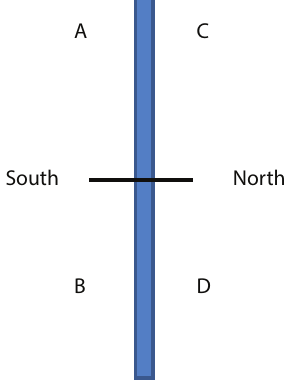
Figure 3. Representation of the orientation and relative